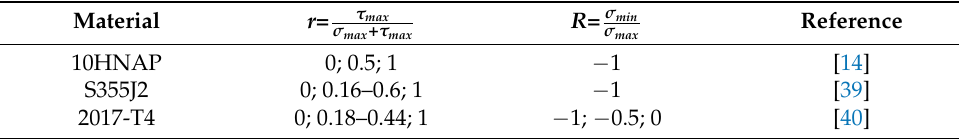
Table 1. Fatigue tests